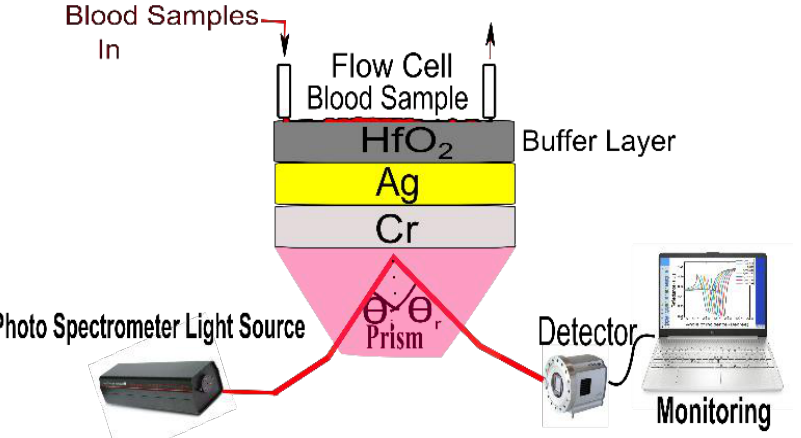
Figure 1. Schematic of the proposed prism-based S.P.R. biosensor for identifying human blood groups.